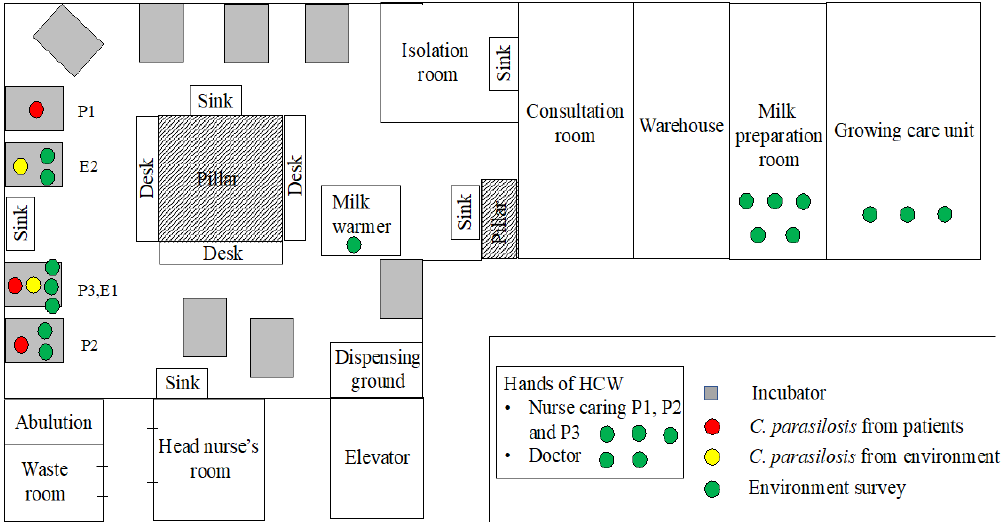
Figure 2. Schematic map of the ward layout of the Kurume University Hospital NICU and the locations where C. parapsilsilosis strains were isolated. The gray rectangles represent incubators. The red circles represent C. parapsilosis isolates, sampled from patients. The yellow circles represent C. parapsilosis isolates, sampled from the environment. The green circles represent the environmental cultures from the NICU. NICU: neonatal intensive care unit, HCW: health care worker.